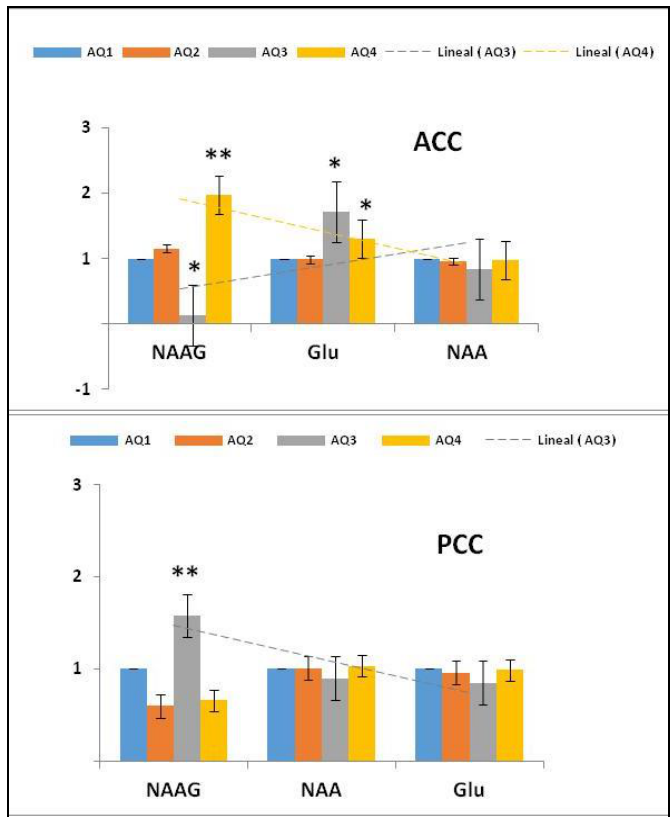
Figure 5. Mean absolute concentrations of NAA, NAAG, and Glu in NAAG metabolism in the ACC and PCC within each AQ group (AQ1 = 28.3%, n = 17; AQ2 = 43.3%, n = 26; AQ3 = 10.0%, n = 9; AQ4 = 18.3%, n = 13), with the AQ1 group taken as a reference or control and the AQ index as a marker of ASD severity. Standardized graph, p < 0.05 considered significantly different. *, **, significant at p < 0.05; 0.01; respectively.